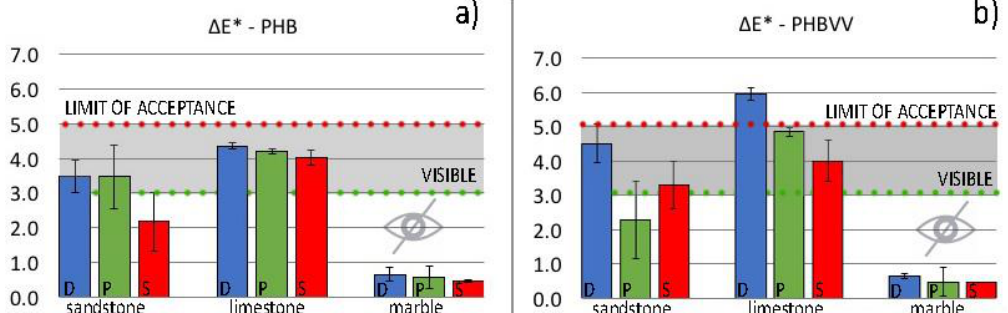
Figure 7. Colour alterations ( Δ E* ) determined by spectrophotometry on sandstone, limestone and marble: ( a ) before and after the application of PHB-based treatment; ( b ) and before and after the application of PHBVV-based treatment. The three application methods are represented as D (dip- coating, blue bars), P (poultice, green bars) and S (spray, red bars).